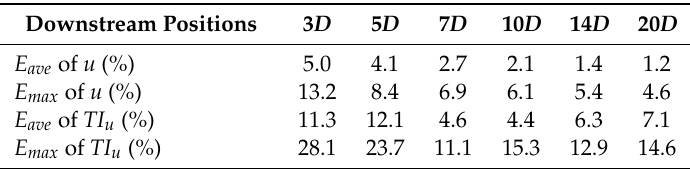
Table 3. The simulation’s relative error at several downstream positions behind the turbine. Note that numerical results are obtained by the AD / RANS_RSM method with the anisotropic inflow condition, and the overall TI is introduced for far wake positions (as illustrated in Figure